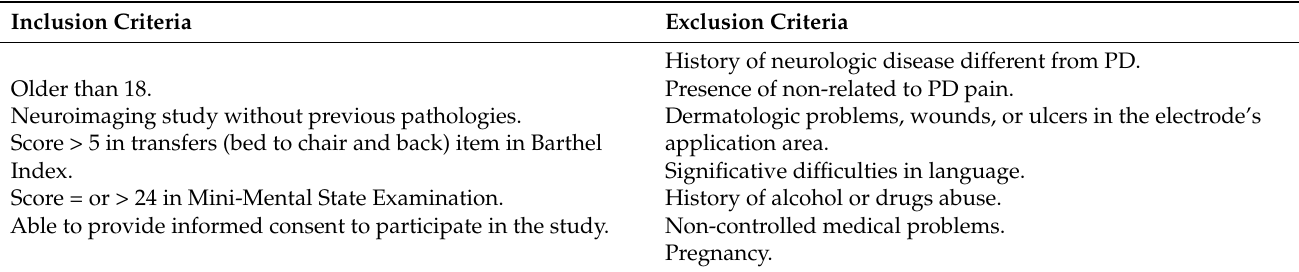
Table 2. Additional inclusion and exclusion criteria for AO+MI-based study. Inclusion Criteria Exclusion Criteria Older than